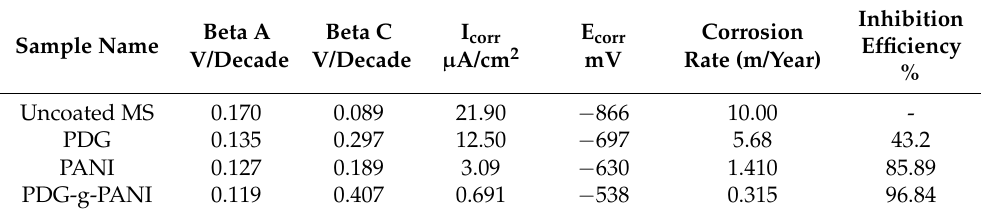
Figure 9. Tafel plot of uncoated MS, PDG-coated, PANI-coated, and PDG-g-PANI-coated MS. Table 2. Comparison of essential corrosion kinetic parameters of uncoated MS, PDG-coated, PANI- coated, and PDG-g-PANI-coated MS in 3.5% NaCl solution.